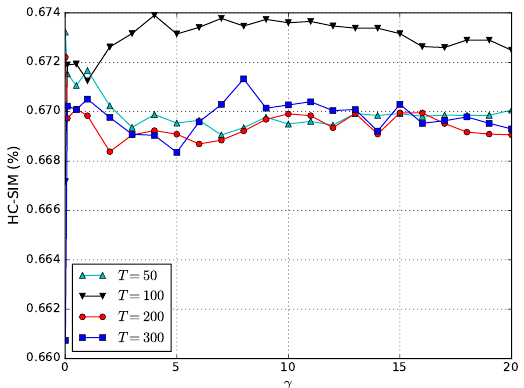
Figure 7. HC-SIM (in %) of the soft-DTW centroid estimate relative to the ground truth trajectory when γ varies for T = 50, 100, 200 and 300.